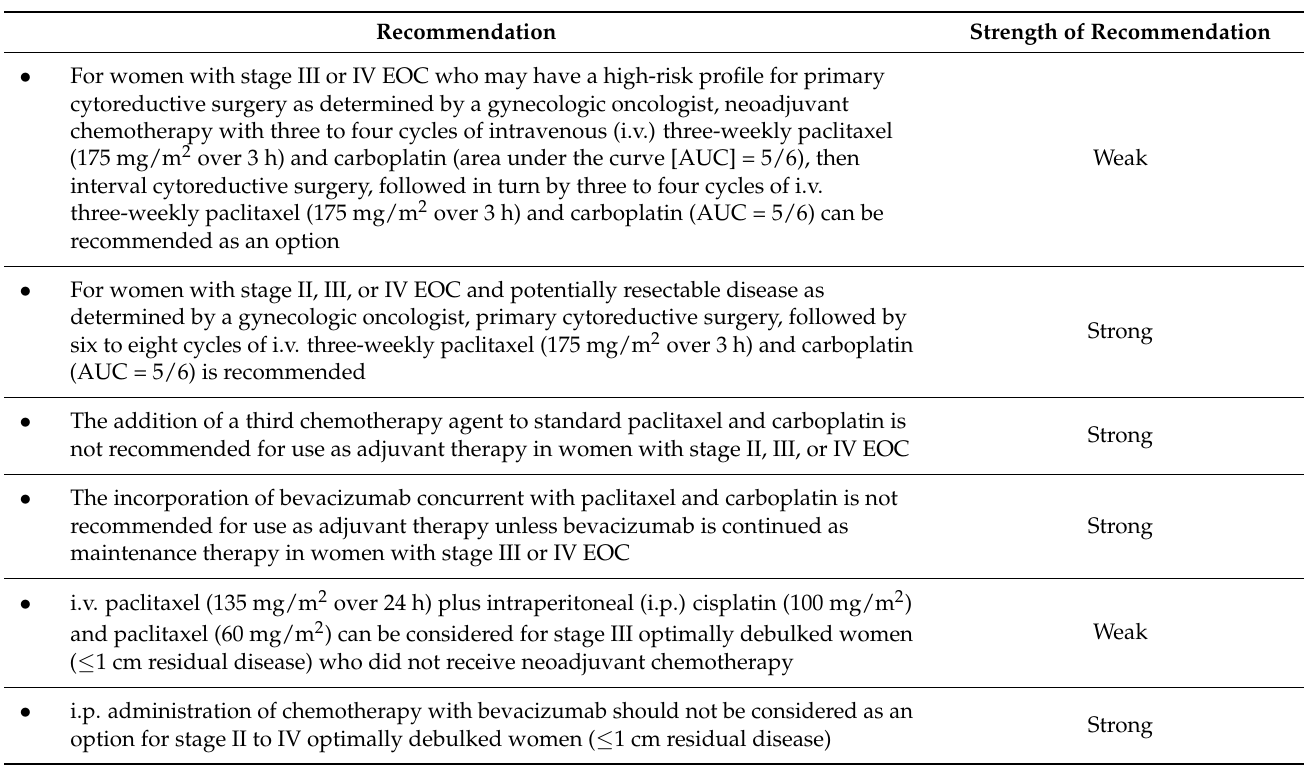
Table 2. Summary of